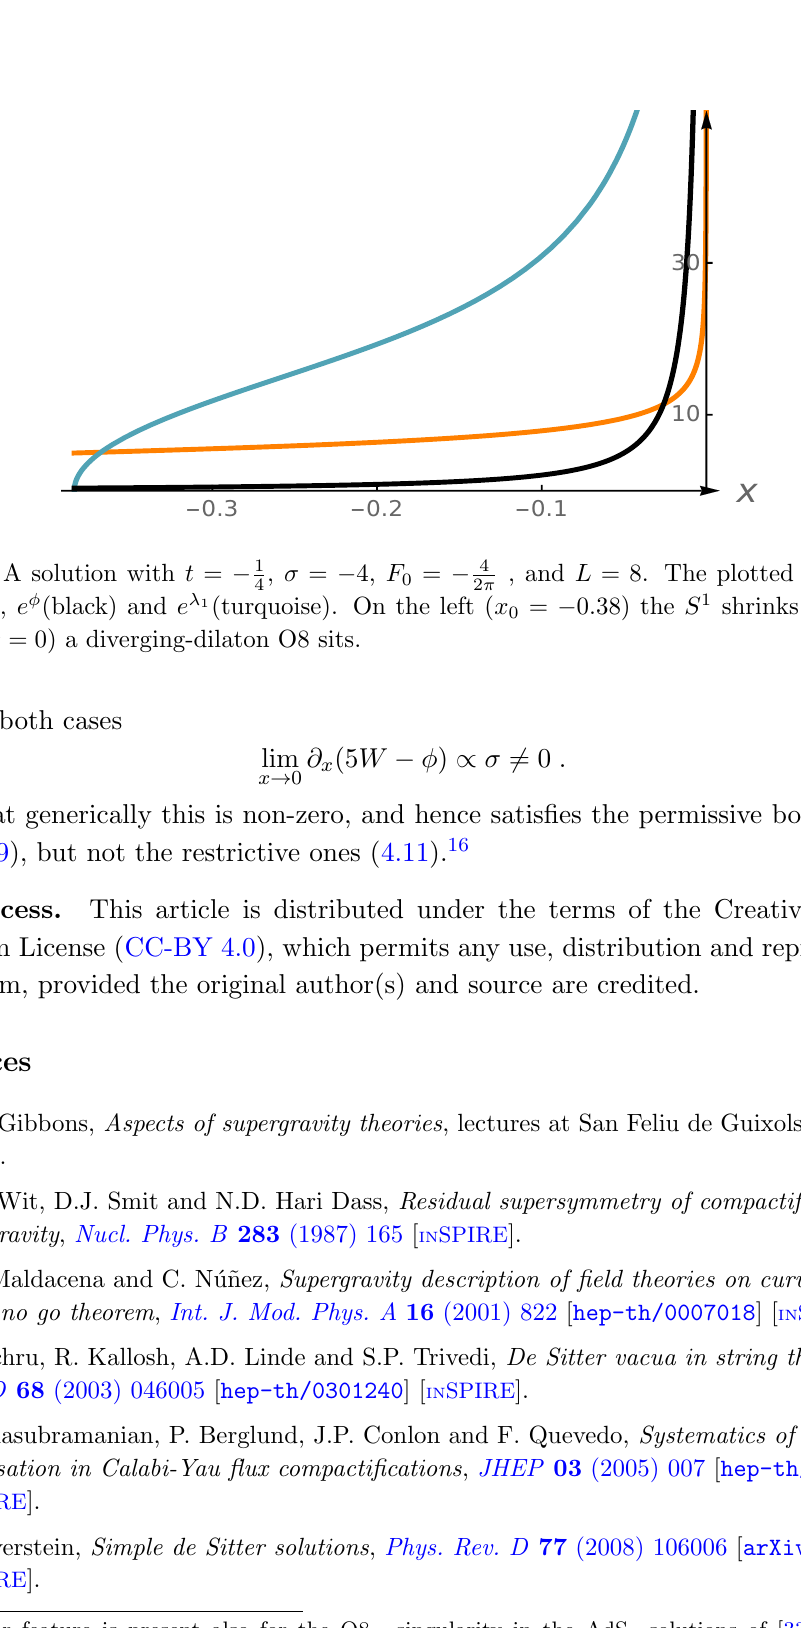
, (cid:27) = (cid:0) 4, F = (cid:0) 4 , and L = 8. The plotted functions are 0 4 2 (cid:25)